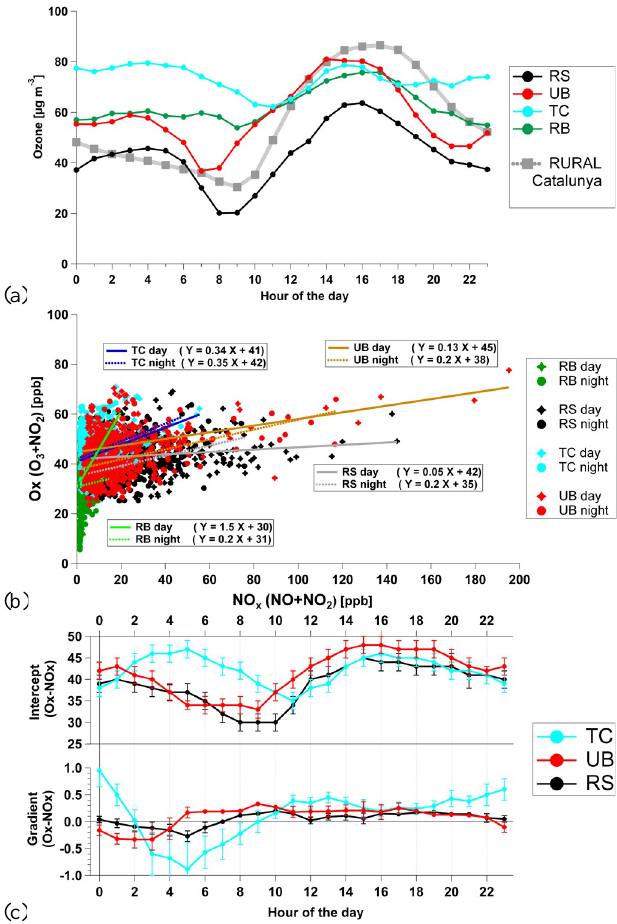
Fig. 10. (a) Diurnal variation of ozone concentrations at 4 SAPUSS monitoring sites (RS, UB, TC, RB) and at REGIONAL Catalonia (average of 7 monitoring stations at regional sites in the province of Catalonia); (b) oxidant plot of the variation in volume mixing ratio of Ox (NO 2 + O 3 ) as a function of NO x (NO + NO 2 ) for 4 SAPUSS sites. Data are for day (08:00–16:00) and night (20:00– 08:00) hourly averages for the whole SAPUSS campaign period; (c) variation in the intercept and gradient of the regression analyses of oxidant plots (as shown in Fig. 12b), for each hour of the 24h period averaged over the campaign